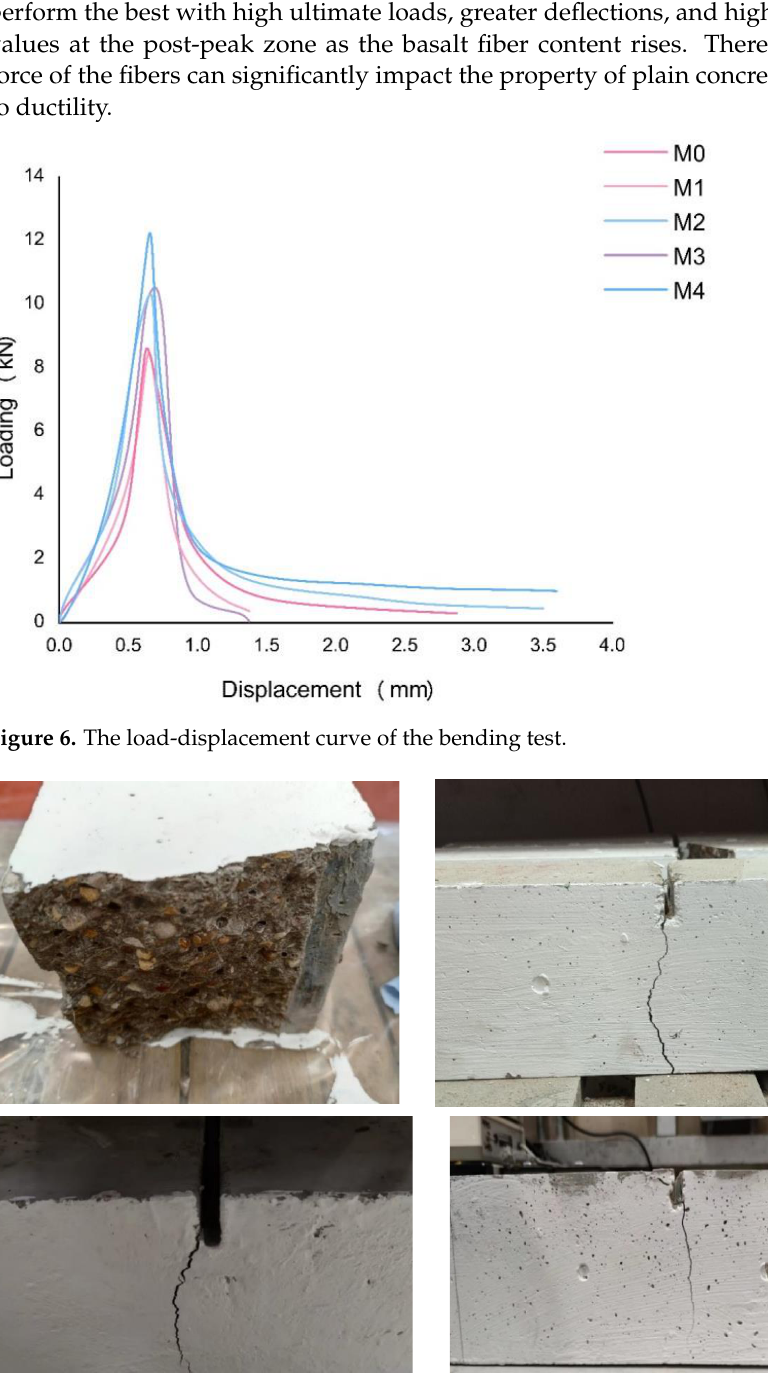
Figure 5. The Load-CMOD curve of the bending test (3.5 mm and 1.0 mm).